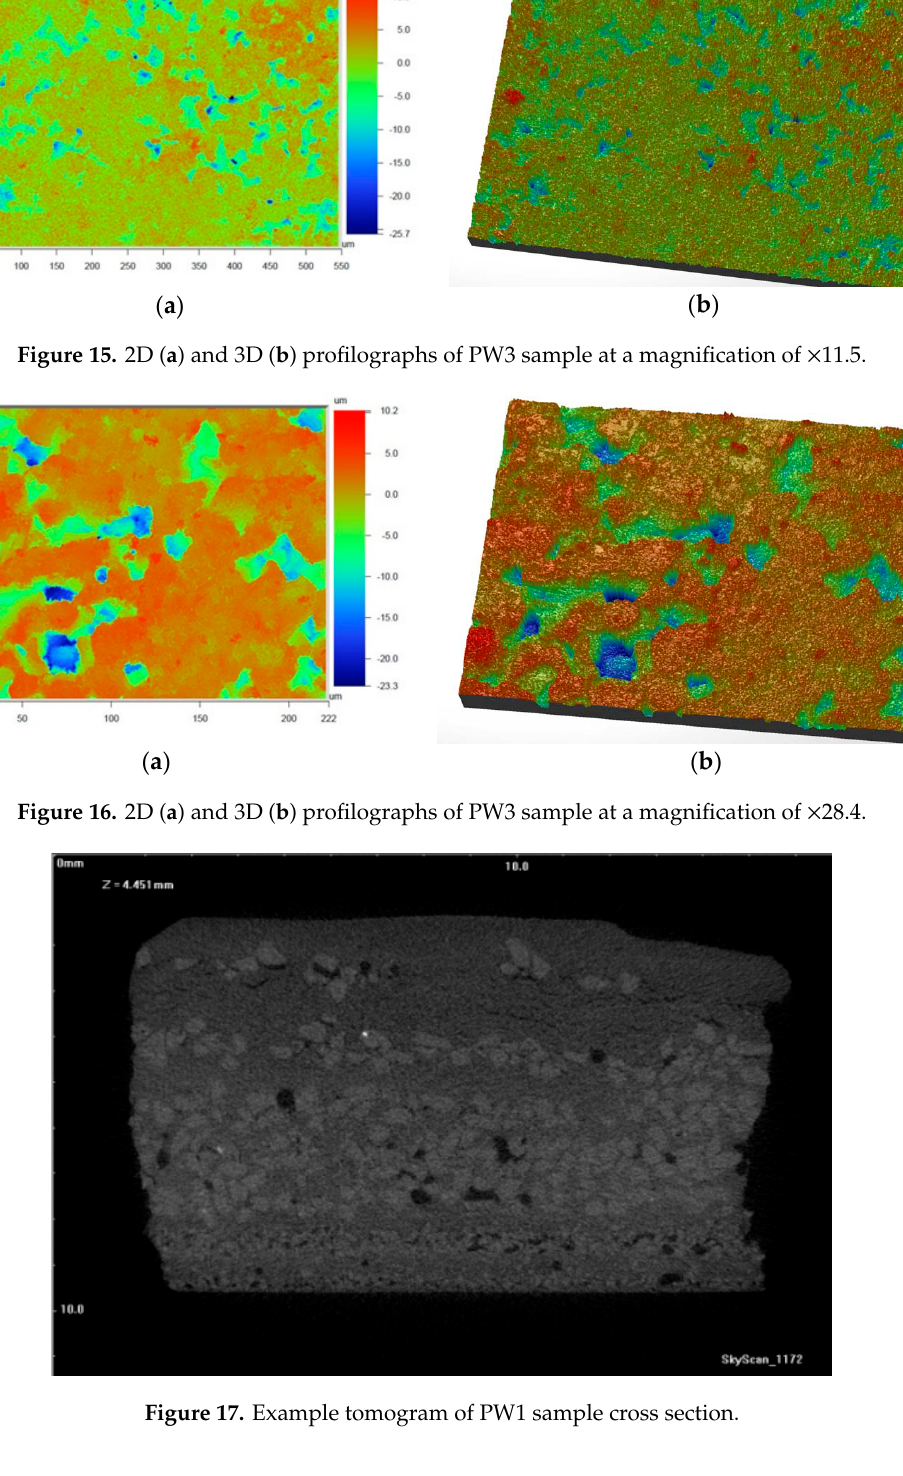
Figure 17. Example tomogram of PW1 sample cross section.